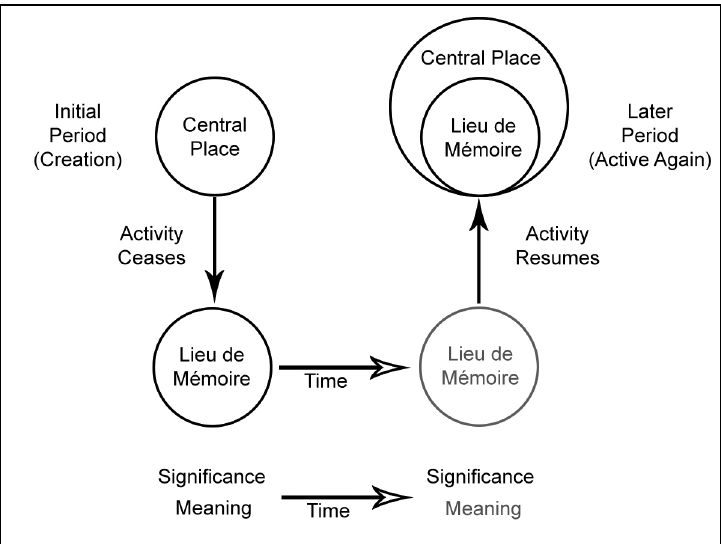
Figure 1: The Relation- ship between lieux de mémoire and central